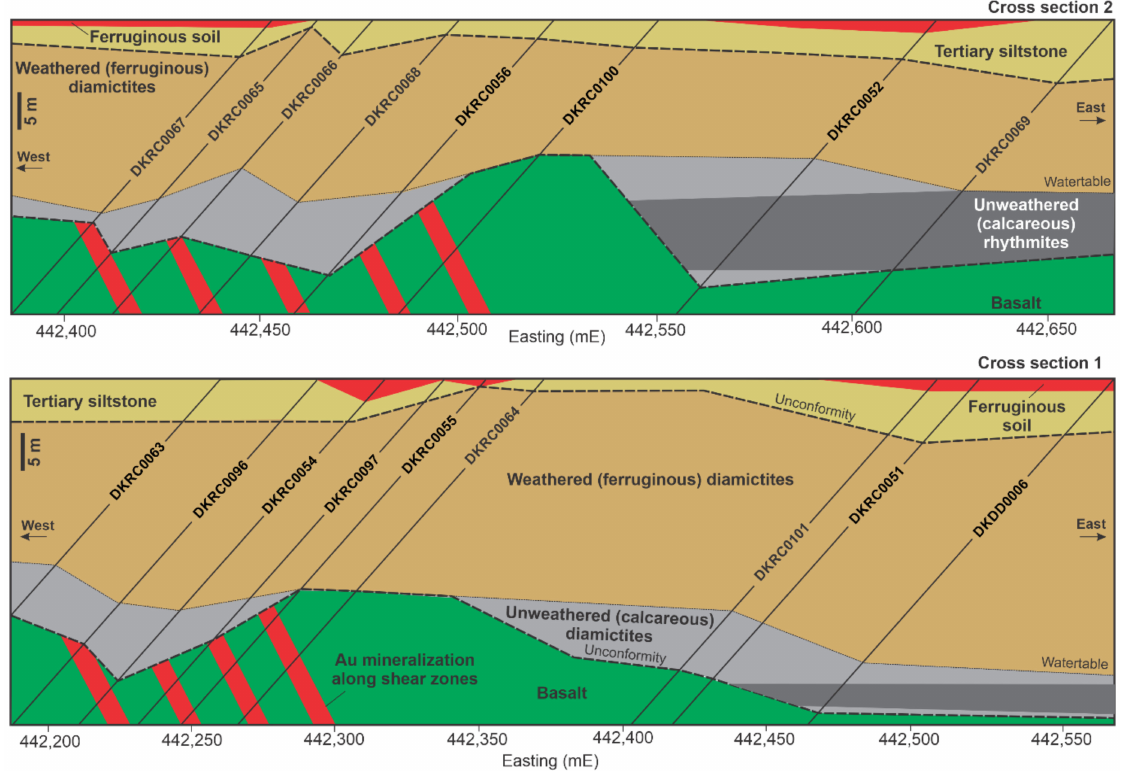
Figure 3. Two stratigraphic cross sections (Figure 2) showing the lateral and vertical variations in the Permian–Cenozoic cover and the basement paleotopography at the Lancefield North prospect. The two cross sections are drawn to the true thickness, with no vertical